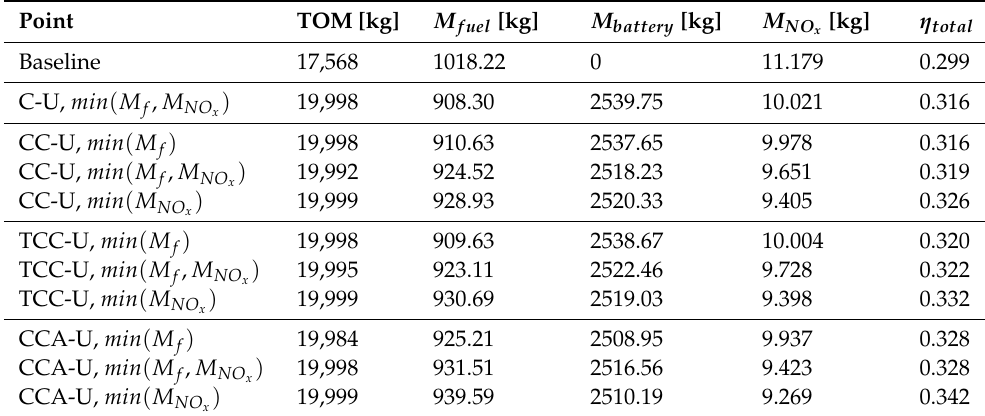
Table 10. Detailed results of the points in Figure